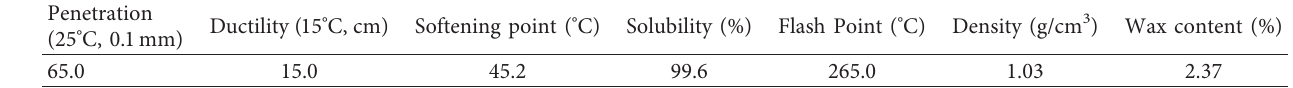
Table 3: Properties of asphalt emulsion.